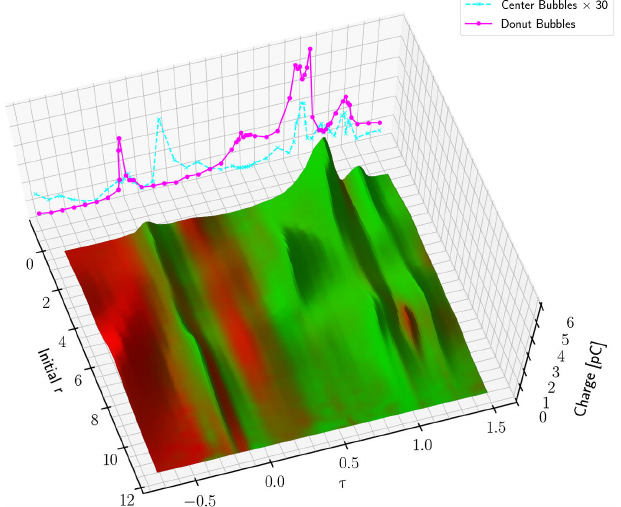
FIG. 3. The charge of injected positrons as a function of initial off-axis distance and delay in the front three consecutive donut and center bubbles. The value is the total charge, and the color denotes which kind of bubble is dominant, green (red) color means positron charges are mainly from center (donut) bubbles as an